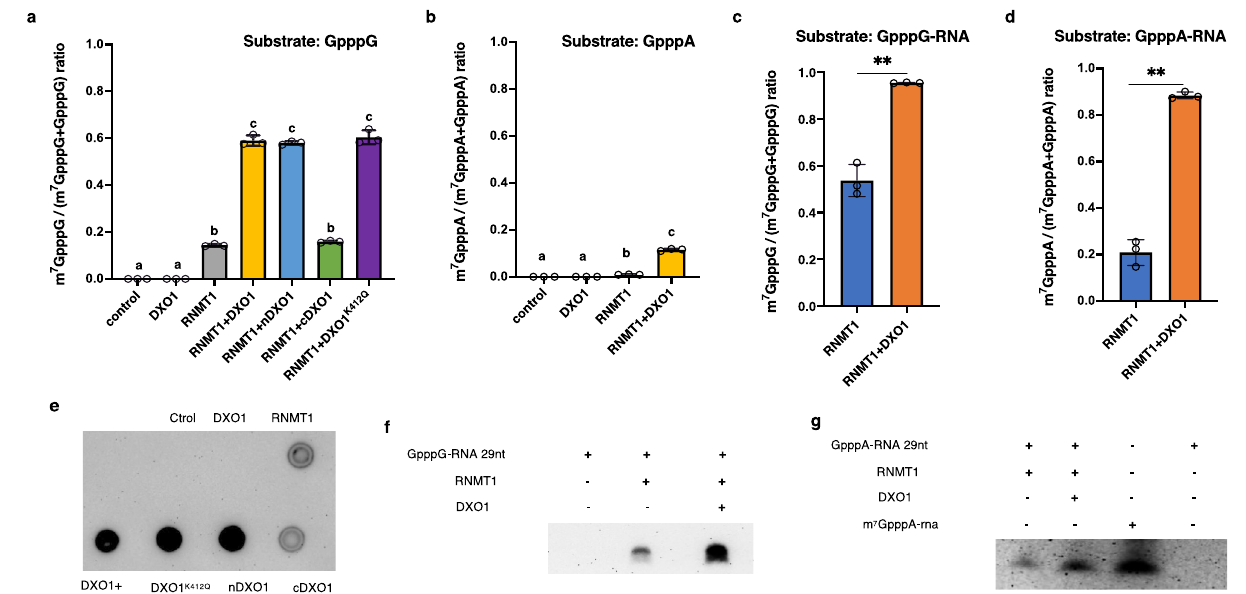
Fig. 3 | RNMT1 is an RNA cap methyl transferase and activated by DXO1. Con- version of GpppG ( a ), GpppA ( b ), GpppG-RNA (29-nt ( c ), and GpppA-RNA (29-nt ( d ), to m 7 GpppG, m 7 GpppA, m 7 GpppG-RNA, and m 7 GpppA-RNA, respectively, by RNMT1 alone or with DXO1, nDXO1, cDXO1, and DXO1 K412Q . Control: the reaction withnoprotein.m 7 GpppA-RNAandm 7 GpppG-RNAweredigestedbynucleaseP1to release GpppA, GpppG, m7GpppA, and m7GpppG, which were detected and quanti fi edbymassspectrometry.Differentlettersindicatesigni fi cantdifferenceby one-way ANOVA, Tukey ’ s test ( p <0.05) ( a , b ). ** indicates p < 0.01 determined